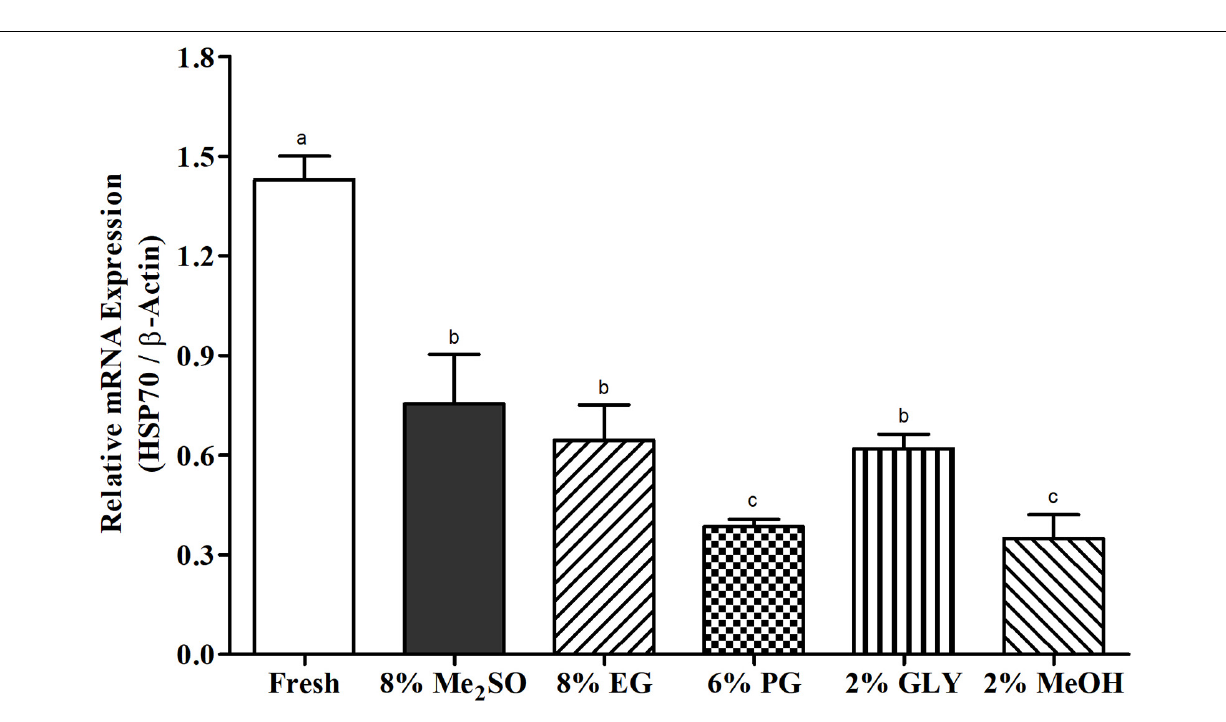
FIGURE 2 | HSP70 mRNA expression levels in fresh and cryopreserved sperm samples ( n = 3) of Pacific abalone, H. discus hannai . Expression values of HSP70 mRNA were normalized against average (cid:49) CT values of control. Different superscript letters (a–c) above bars indicate significant ( p < 0.05) differences between fresh and cryopreserved sperm